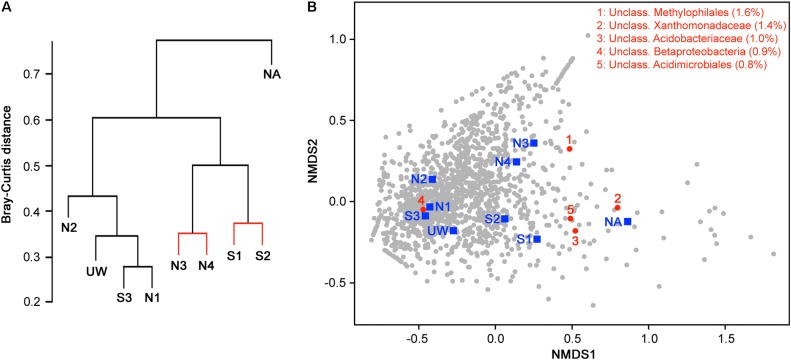
Discrimination of sites on the basis of bacterial community structure. (A) Hierarchical clustering of sample sites based on species similarity. Sites with non-significant clustering (p < 0.05) as determined by SIMPROF are indicated with red lines. (B) Two-dimensional NMDS plot of sites based on species similarity showing a separation between unpolluted sites (UW, S3, N1, and N2), polluted sites (S1, S2, N3, and N4), and the highly polluted mine adit site (NA) on the basis of NMDS1. Assigned taxa assemblage is shown (gray circles) and the top five taxa with the most contribution (% contribution) to site assemblage based on SIMPER analysis are indicated and listed in red.